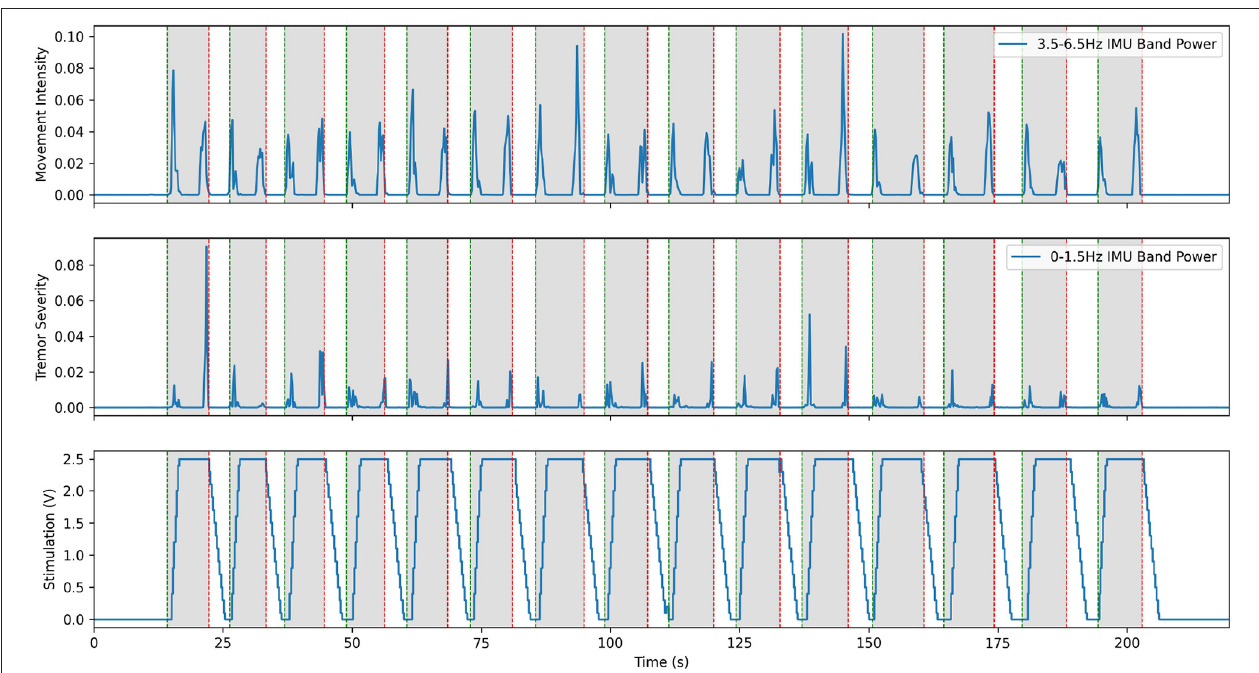
FIGURE 3 | Excerpt from an experiment demonstrating aDBS driven by EMG on the moving arm with Patient 1. The top plot shows the power in the low frequency IMU data, which corresponds to movement. The middle plot shows power in the band of IMU data that corresponds to the patient’s peak tremor frequency. The bottom plot shows the amplitude of stimulation over time, with a constant 150 Hz frequency and 90 us pulse width. Note that tremor is very effectively suppressed in this case, with only very short bursts of tremor at the very start and end of movement. This is a re-illustration of the results of Herron et al.